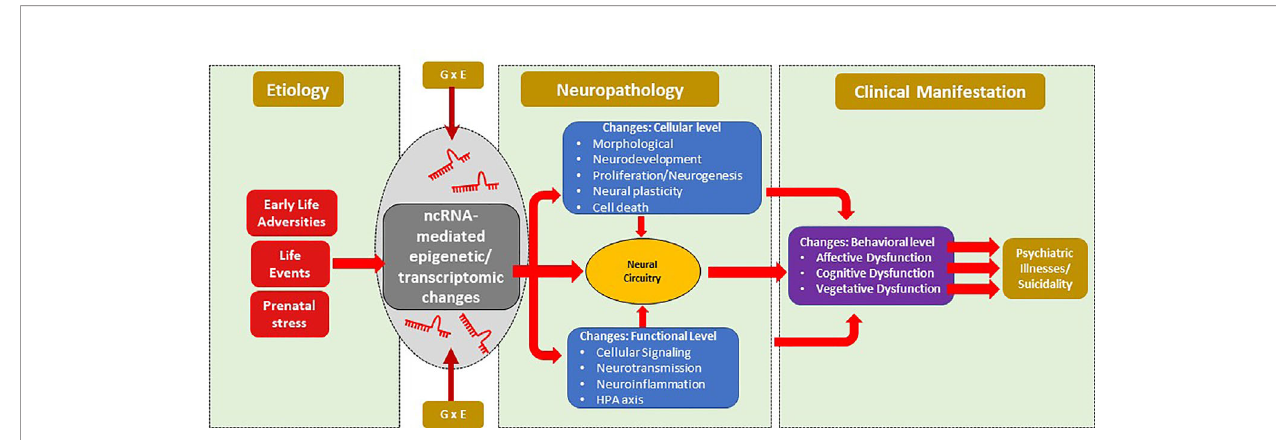
FIGURE 3 | Schematic diagram of the non-coding RNAs ’ impact on psychiatric illnesses and suicidality. Risk factors for mental illnesses include early life adversity, current or recurrent life events that along with gene environment interaction can lead to epigenetic modi fi cations mediated by ncRNAs. These modi fi cations can give rise to neuropathology mediated by changes at cellular and/or molecular levels, which can subsequently alter neural circuitry. Phenotypic changes can arise from circuitry changes that can mediate the development of psychiatric illnesses such as major depression, bipolar disorder and schizophrenia. Suicidal behavior could be a manifestation of psychiatric illnesses or may be independent of psychiatric illnesses. ncRNAs, non-coding